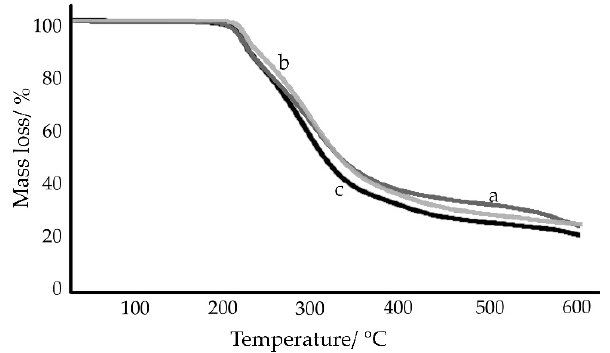
Figure 11. TGA curves for saccharin salts of chlordiazepoxide prepared using the following methods: ( a ) liquid-assisted grinding, ( b ) crystallization from ACN, and ( c ) crystallization from MeOH/ClMe. Measurements were taken at a heating rate of 10 °C/min in nitrogen.